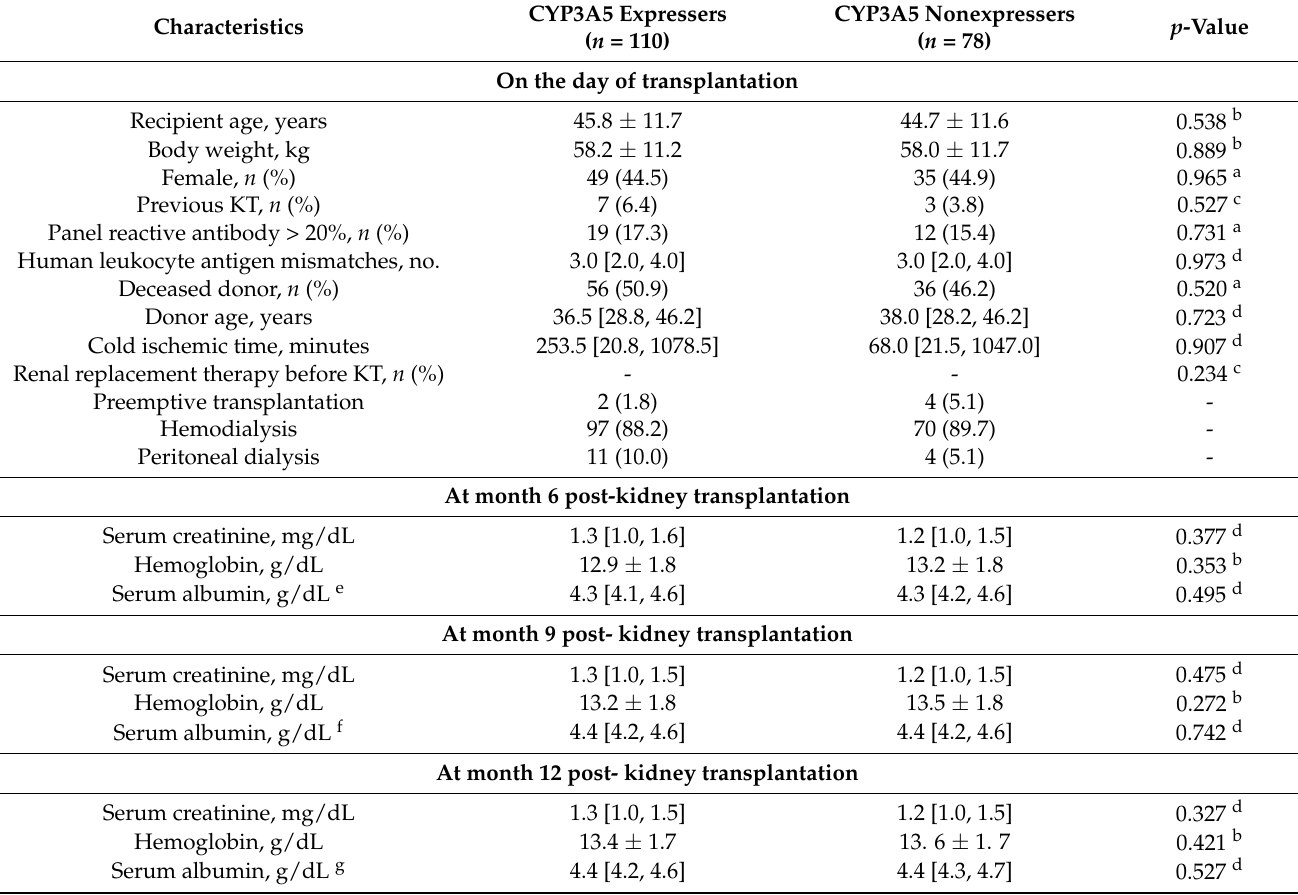
Table 1. Patient